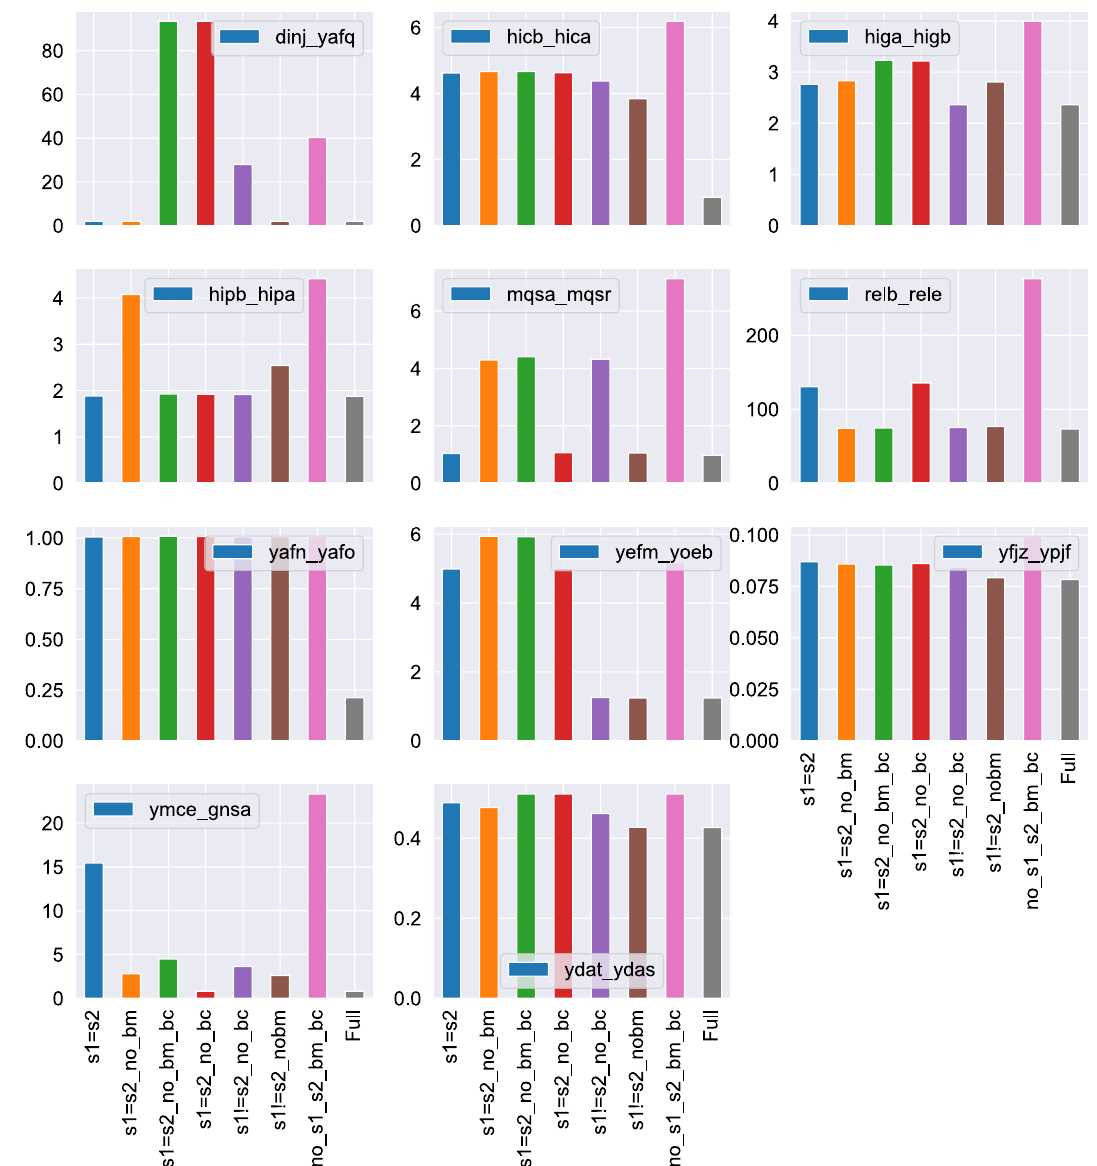
Figure 6. The values of the objective function for all TA pairs and for 7 model variants. The Z-model defined by Eqs. (4)–(6) is marked with the label “Full” in the